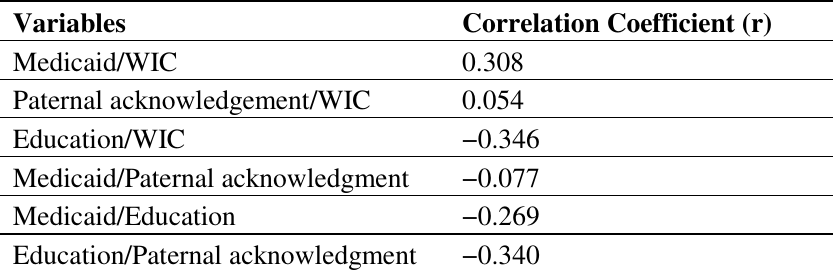
Table A3. Correlation coefficients for SEP